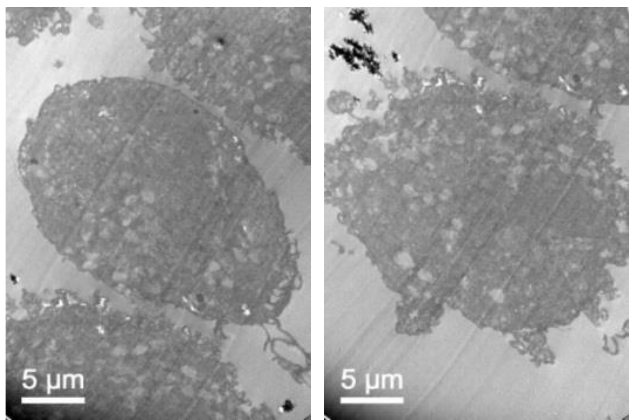
Figure 11. TEM images of pathological fibroblasts from mucopolysaccharoidosis IVA (MPS IVA) patients.